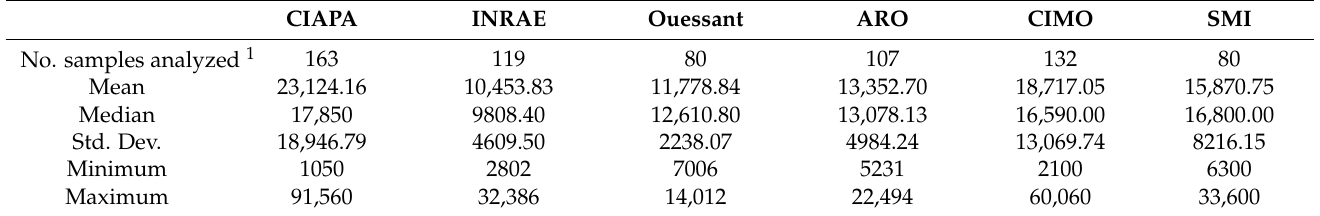
Table 5. Estimation of colony strength for each apiary. Values represent an estimation of the number of honey bee adults.